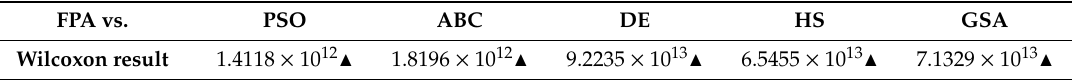
Table 6. p -values of the Wilcoxon test comparing FPA vs. PSO, ABC, DE, HS and GSA. FPA vs.